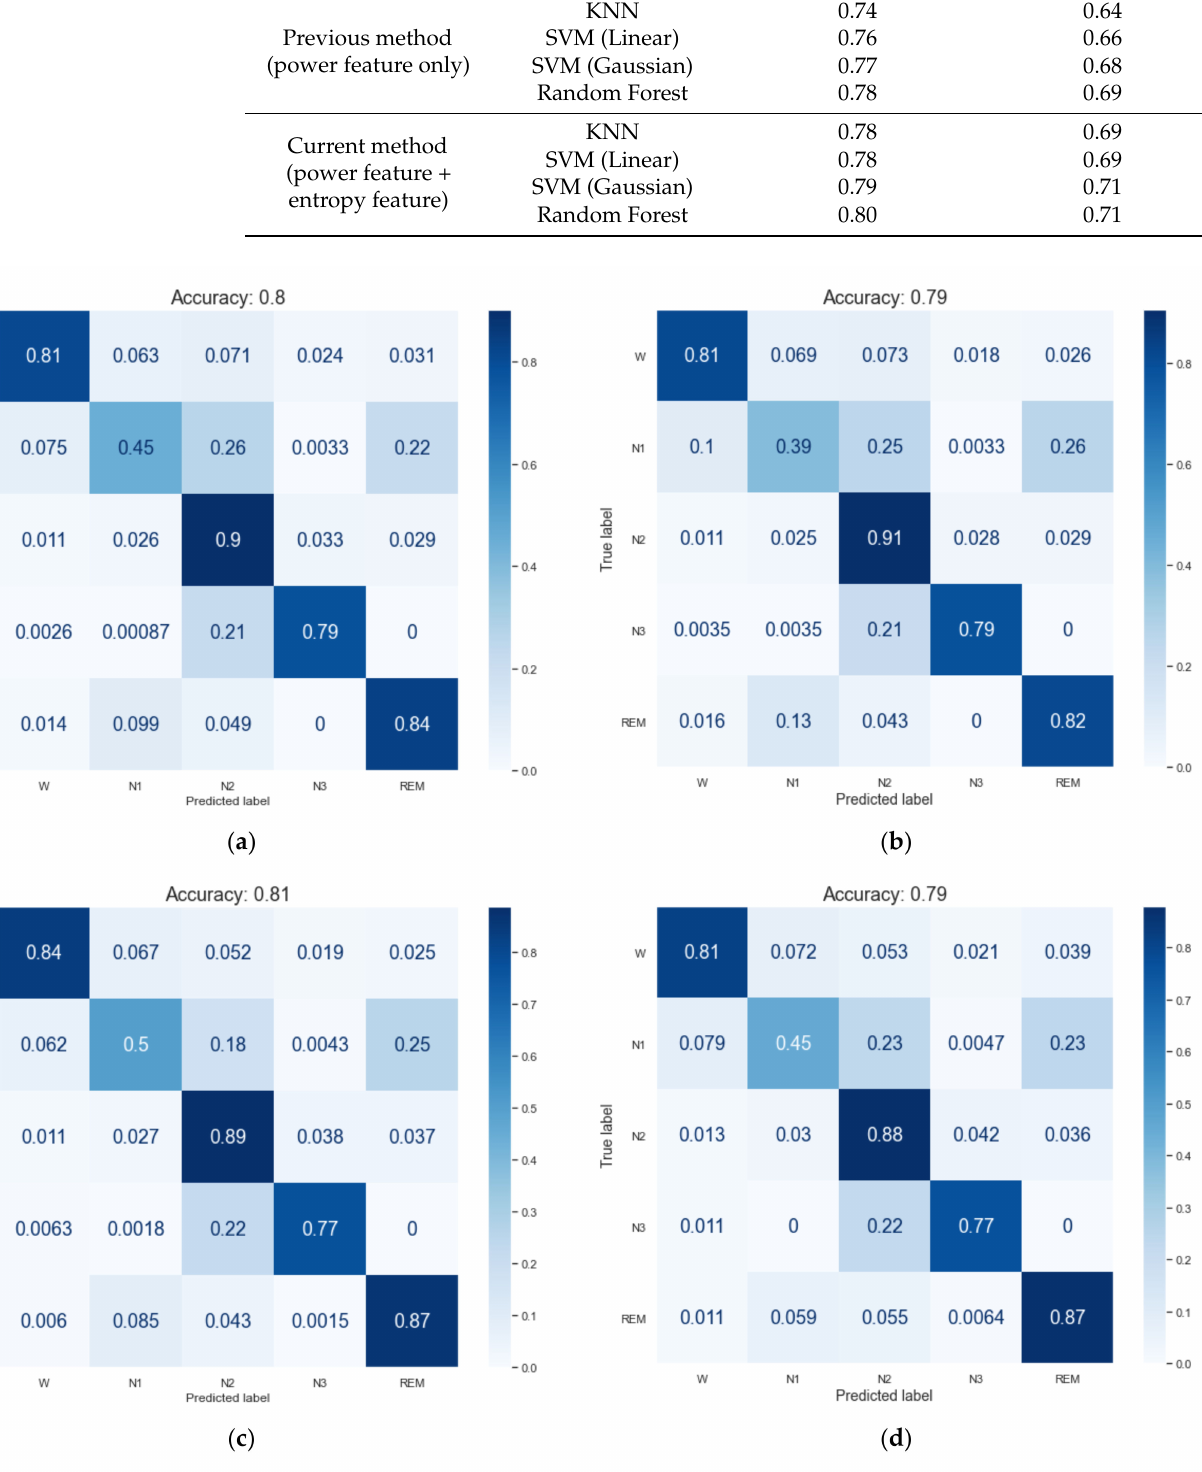
Table 4. Classification results of previous methods (power feature only) and of the new method (power feature + entropy feature).